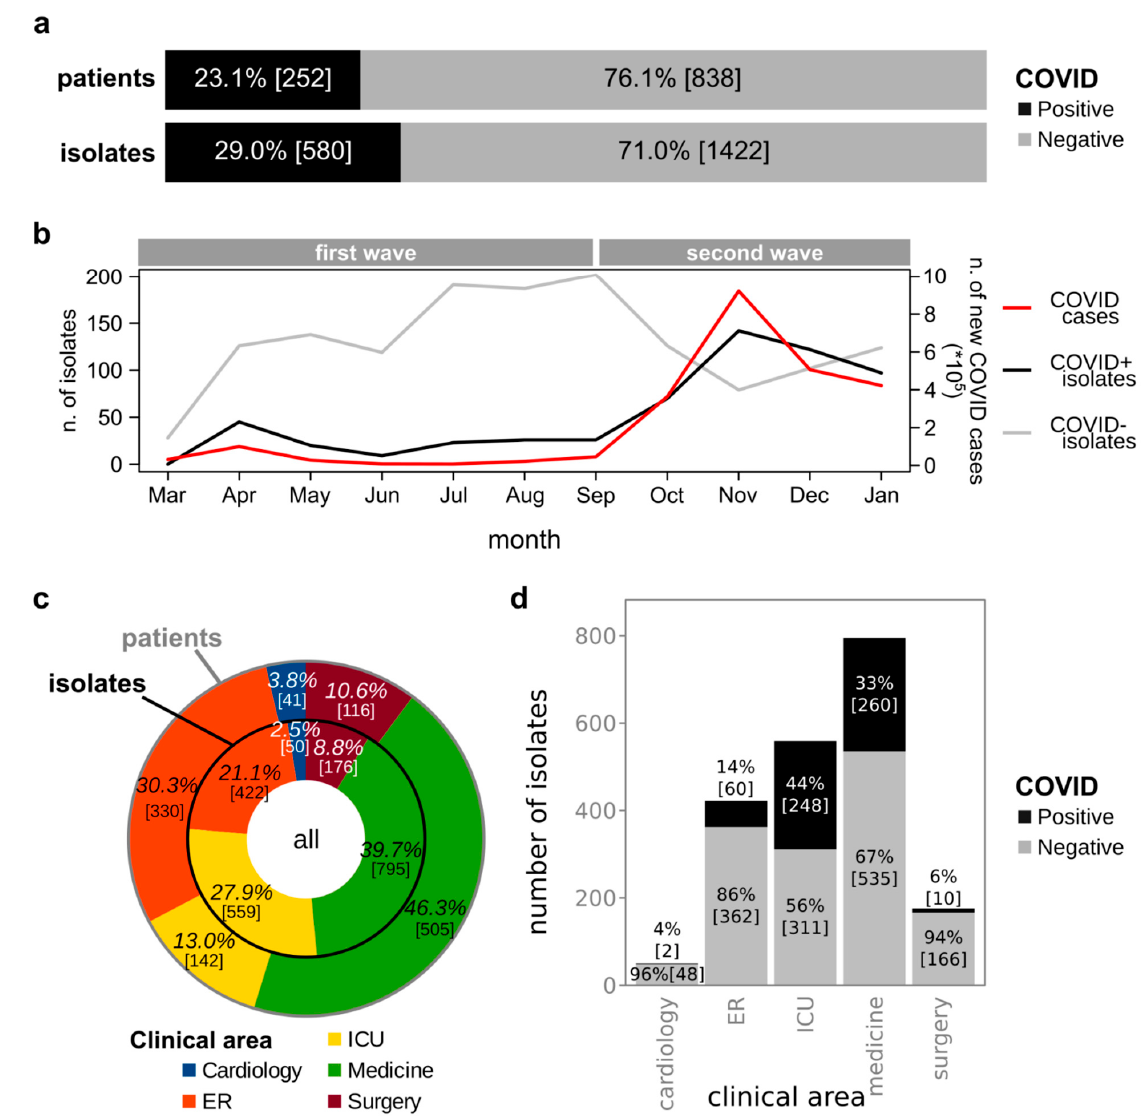
Figure 1. Distribution of samples among patients having been tested positive (COVID+) or negative (COVID − ) for COVID- 19 before collection of samples for microbial analysis. ( a ) Percentages and number of patients (and relative isolates) having been tested positive or negative for COVID-19 before collection of samples for microbial analysis. ( b ) Comparison of trends of new COVID-19 cases in Italy (red line, right vertical axis), bacterial strains isolated from COVID+ patients in our study cohort (black line, left vertical axis), and bacterial strains isolated from COVID − patients in our study cohort (grey line, left vertical axis). The time-periods of the first and second pandemic waves in Italy are reported over the plot. ( c ) Distribution of patients and isolates among clinical areas. ( d ) Distribution of isolates from COVID+ and COVID − patients among clinical areas.